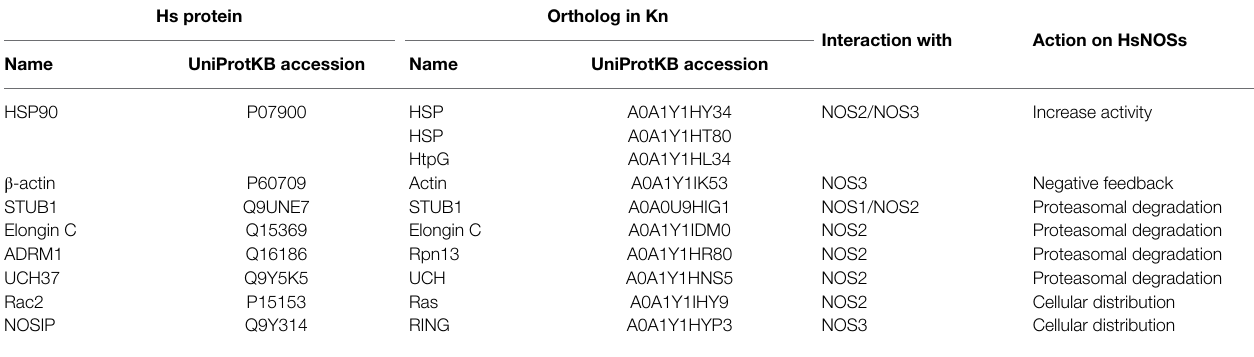
TABLE 1 | List of human NOSs partners identified from the BioGRID database and their orthologs in Klebsormidium nitens genome. Hs protein Ortholog in Kn